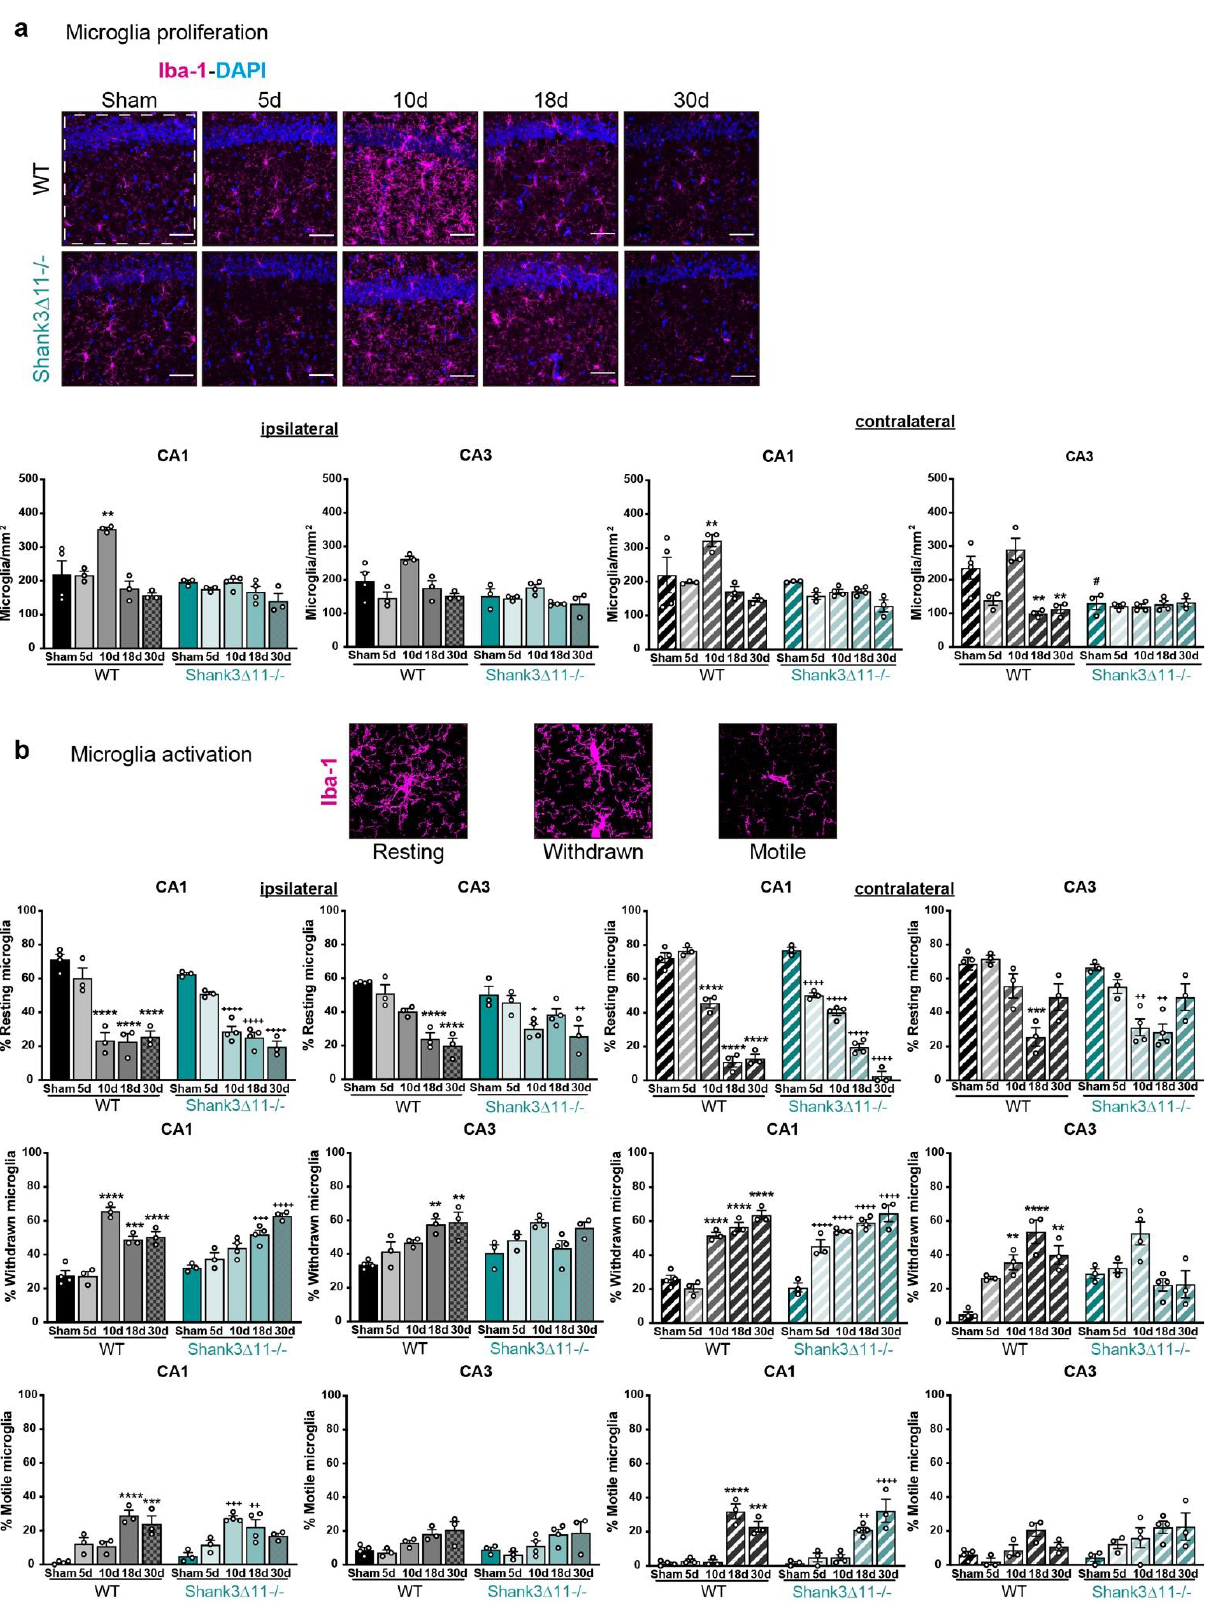
Figure 4. Microglial proliferation was only observed in WT animals, while its activation is similar in both wild-type and Shank3 ∆ 11 − / − mice after mTBI. ( a ) Microglia were stained using the microglial marker Iba-1 (magenta) and nuclei were stained with DAPI (blue). Representative images are shown for each time point assessed for the CA1 hippocampal region on the left panel, WT mice (left